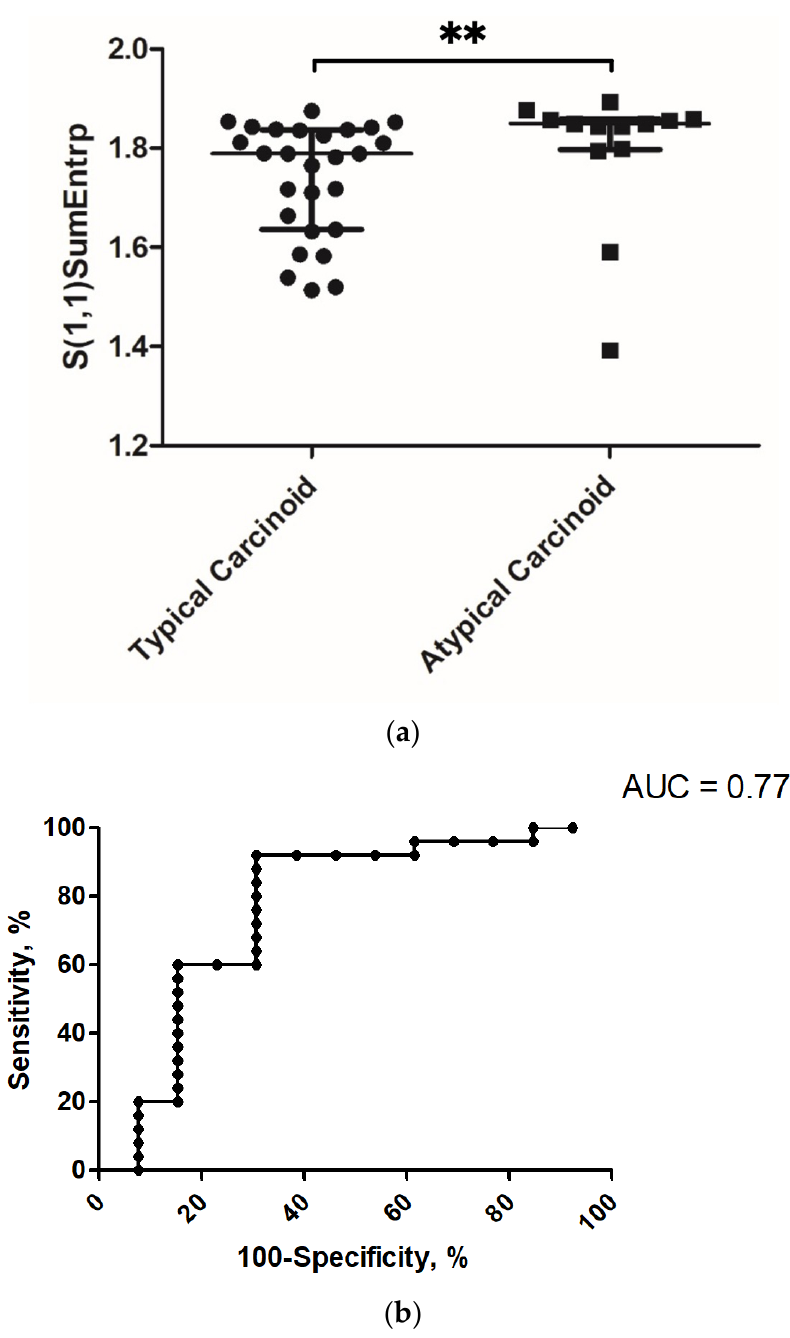
Figure 2. ( a ) Discrimination analysis between typical and atypical carcinoids. The parameter “S(1,1)SumEntrp” reached statistical significance (Mann–Whitney test) mean 1.74 ± 0.11 versus 1.79 ± 0.14, p = 0.007, ** p < 0.01). ( b ) ROC graph for the discrimination analysis between typical